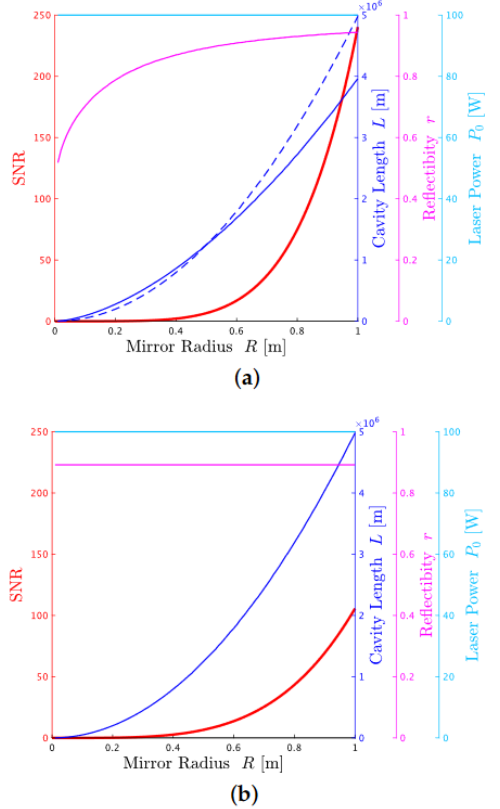
Figure 7. Optimized SNR for a given R (red line), and the cavity length L (blue line), mirror reflectivity r (magenta line), and laser power P 0 (cyan line) which give this SNR. ( a ) shows the case in which the mirror mass increases linearly with the squared mirror radius R 2 in Equation (32), i.e., the constant mirror-thickness case, and ( b ) shows the case of constant mirror mass: 100 kg. Note that the dashed blue curve is the same as the solid blue curve of ( b ) added to compare the optimized length in both